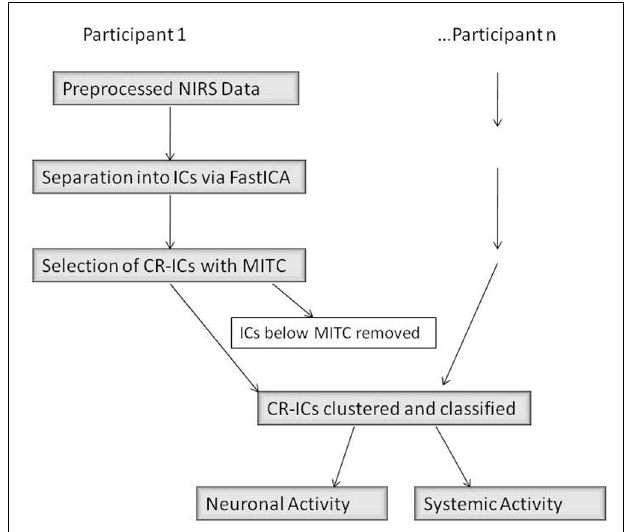
FIGURE 4 | ICA DataAnalysis Diagram (adapted from Katura et al. (2008)) . IC, independent component; CR-IC, condition-related independent component; MITC, mean inter-trial